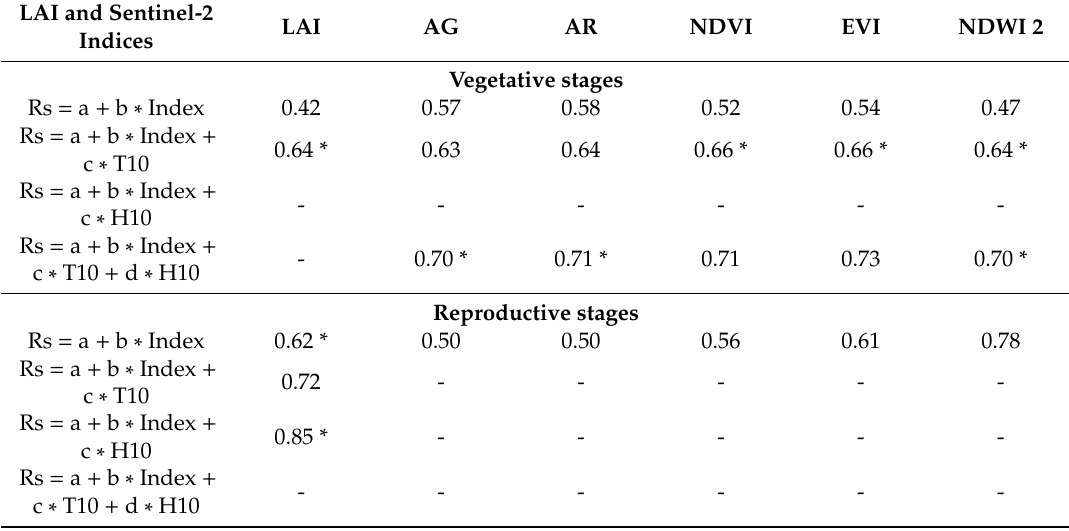
Table 7. Coe ffi cients of determination (R adj2 ) of simple and multiple linear regression models for Rs, as a function of LAI, Sentinel-2 spectral indices, soil temperature (T10) and soil moisture (H10) for both years for the vegetative ( n = 22) and reproductive stages ( n = 18) in a rainfed barley crop ( Hordeum vulgare L.) in Madrid,